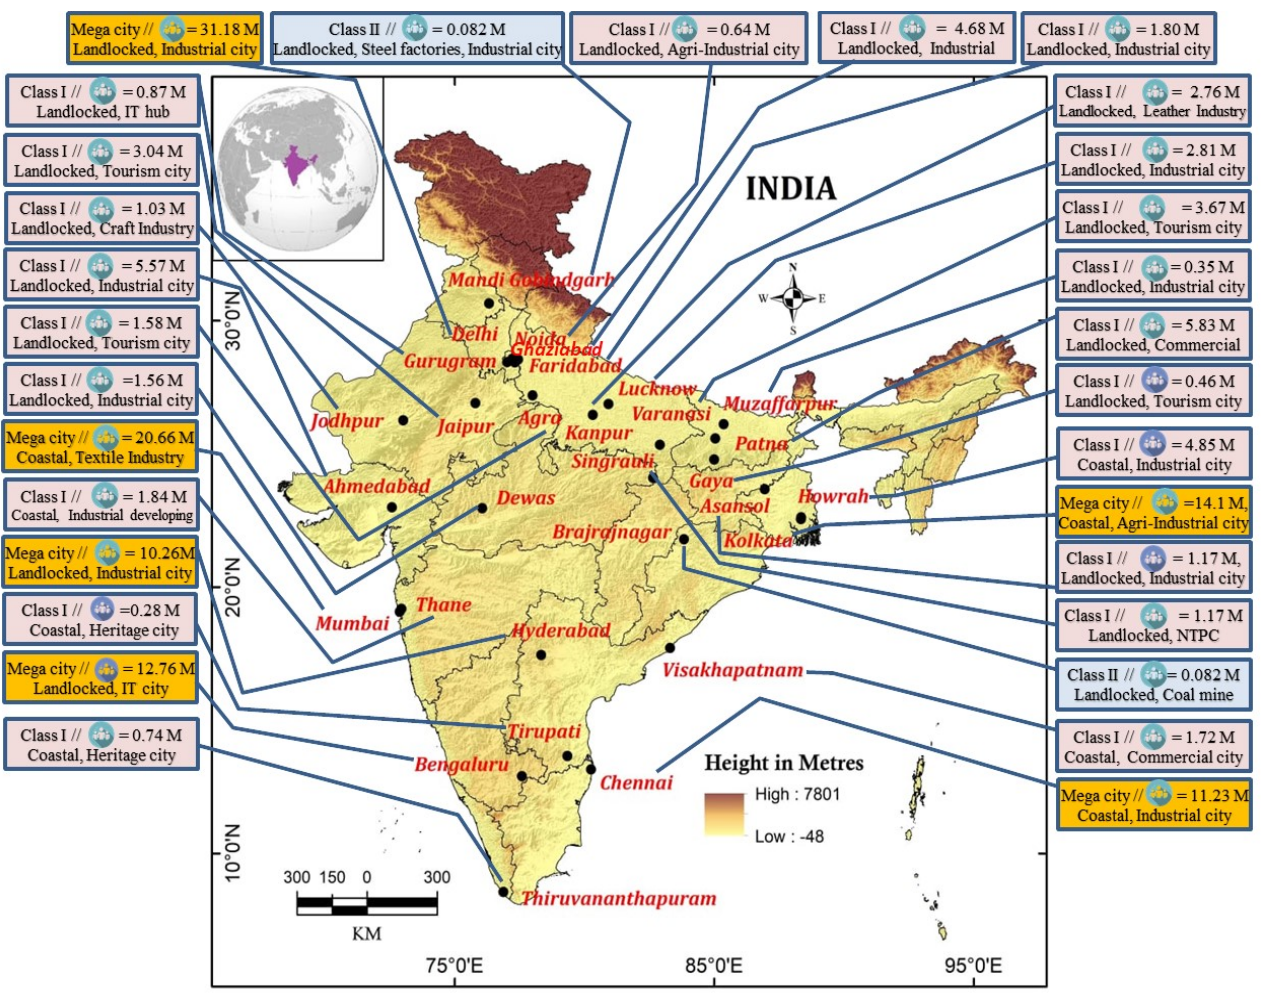
Figure 1. Elevation map of selected Indian cities with their characters and existing population. # IT = Information technology; NTPC = National thermal power corporation; M = Million.